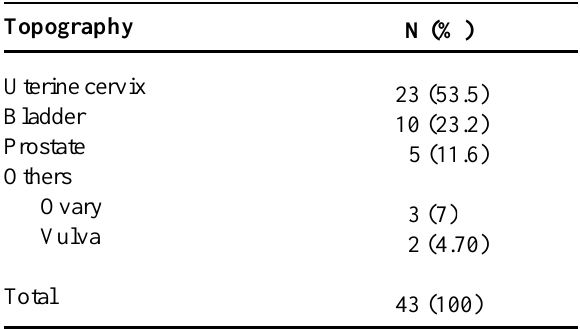
Table 1 – Sites of primary